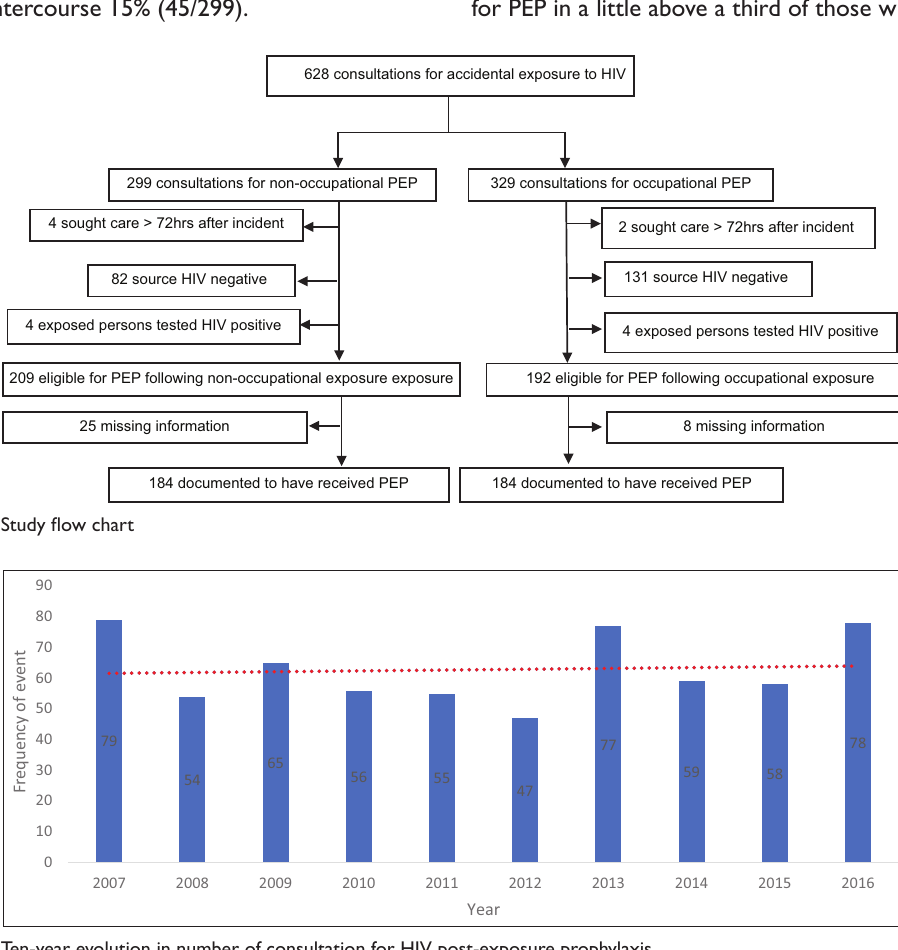
Figure 2: Ten-year evolution in number of consultation for HIV post-exposure